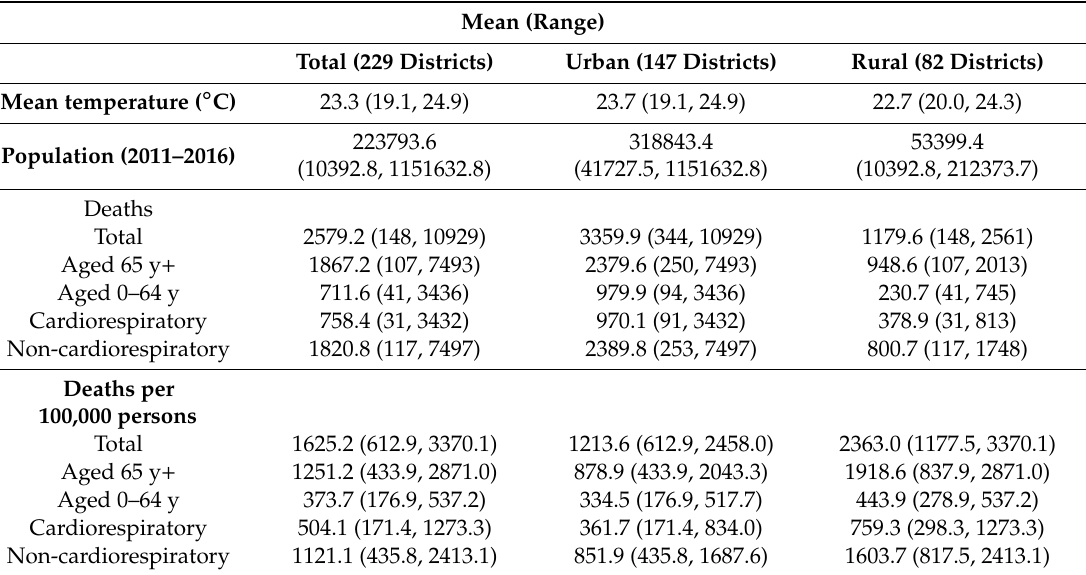
Table 1. Descriptive statistics of the mean temperature and daily mortality in the total, urban, and rural areas during the summer of 2011–2017. Data are averages of mean temperature (range), population (range), death counts (range), and deaths per 100,000 people (range).